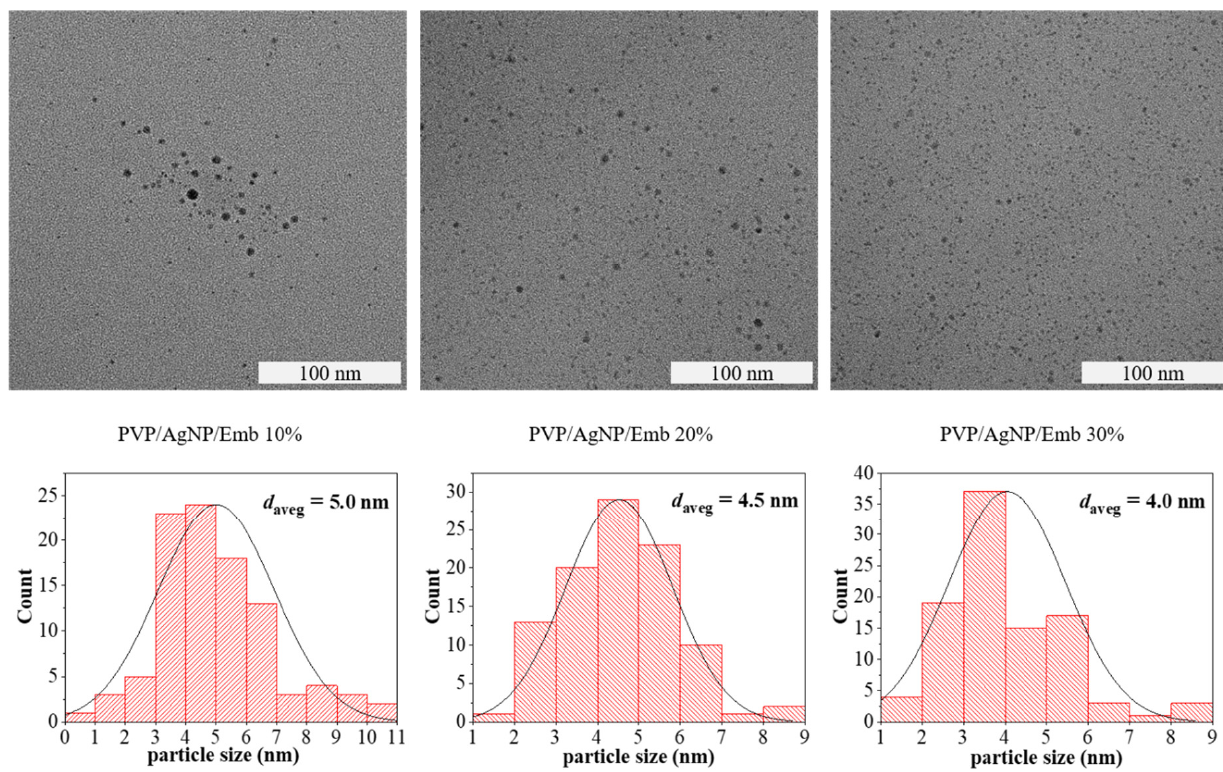
Figure 4. TEM images of silver nanoparticles presented in three different formulations of the dressing spray at 100,000× magnification and the particle size histograms.